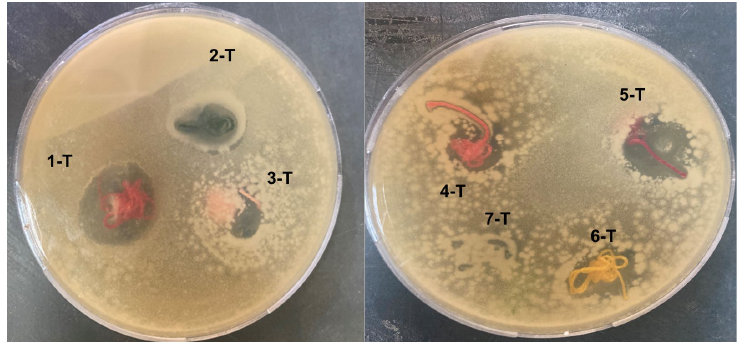
Table 3. Antibacterial properties of coated cotton threads.